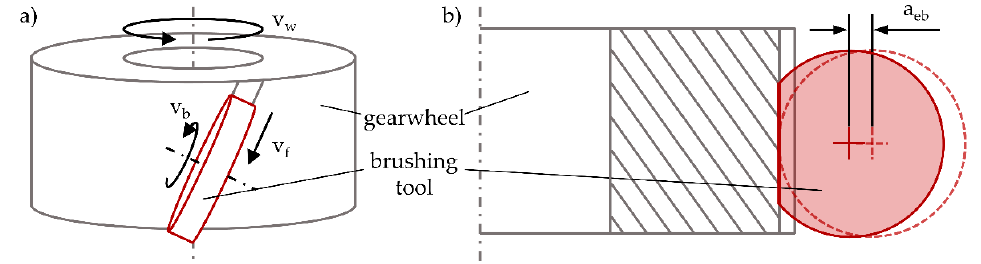
Figure 4. Schematic representation of the process kinematics and parameters when brushing gearwheels; ( a ) 3 ‐ D view; ( b ) Sectional view.